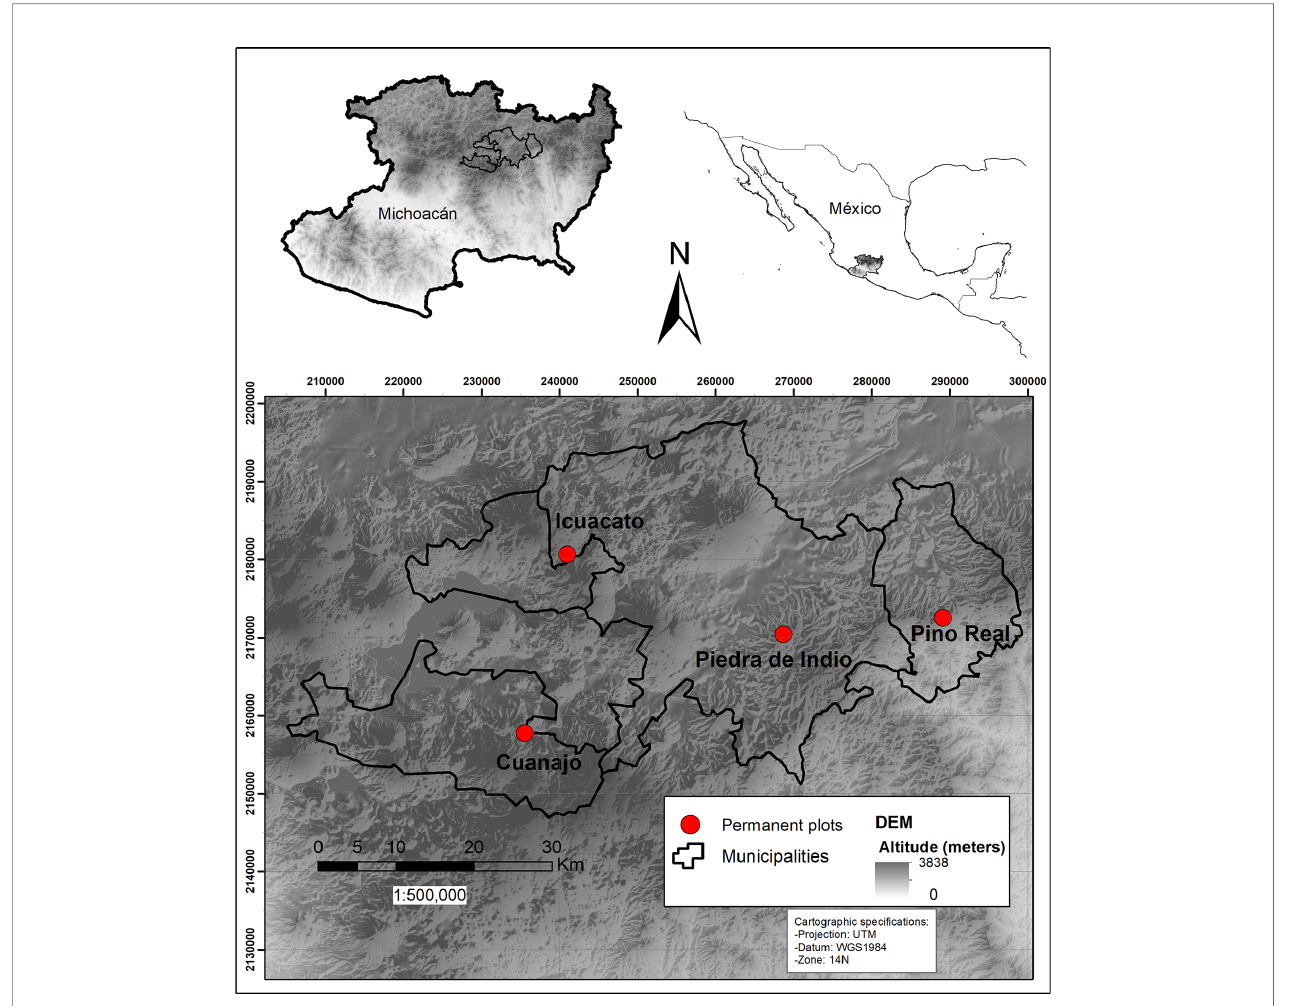
FIGURE 2 | Map of the study area and the location of the four permanent plots in the Trans-Mexican Volcanic